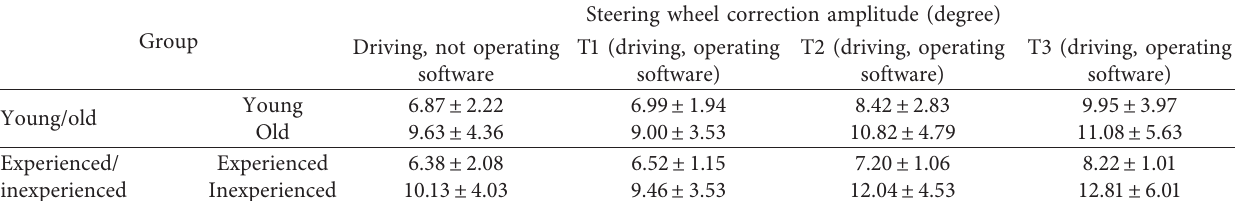
Table 5: Descriptive statistics of mean and standard deviation of steering wheel correction amplitude among different ages and experience